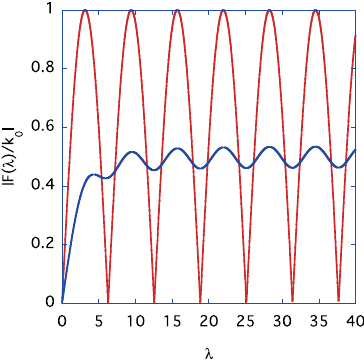
FIG. 1. The absolute value of transfer function for the coupling k ð z Þ ¼ k 0 (red) and that for a ¼ 2 . 63 is